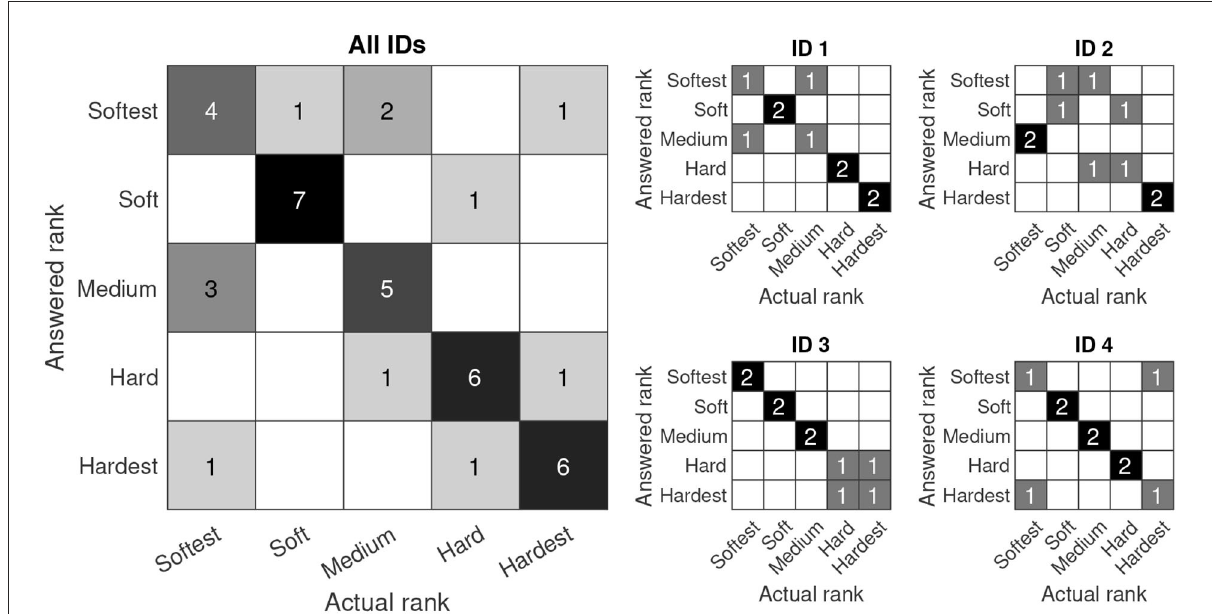
FIGURE3 Confusion matrix of the object sorting task with feedback. In the ideal case, all answers would lie in the diagonal of the confusion matrix. Since the grading is ordinal, errors become more severe the farther they are from the diagonal. (left) Cumulative matrix with observations from all participants; (right) Individual observations per